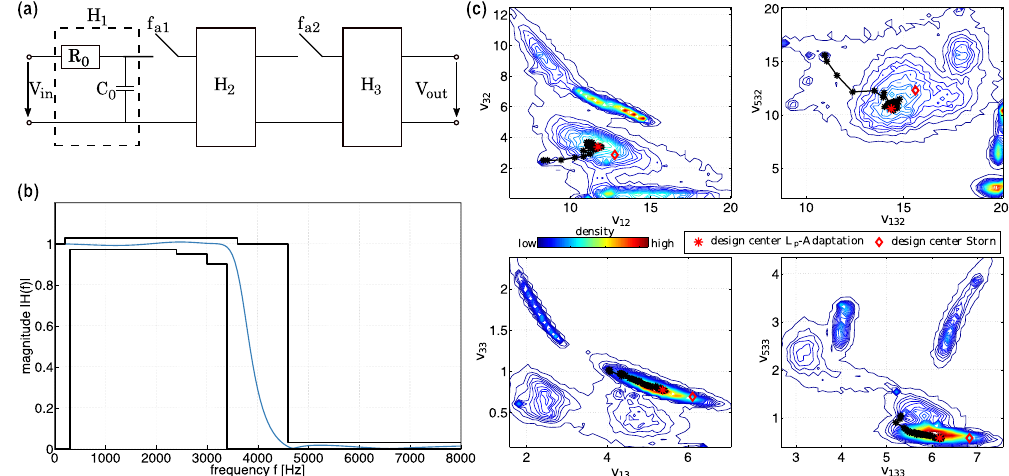
Figure 6. ( a ) Circuit diagram of the Switched Capacitor (SC) filter. ( b ) Specifications for the transfer function of the filter (black lines) and one example satisfying the constraints (blue line). ( c ) Pairwise density contour plots of the feasible points obtained by ten runs of L p -Adaptation with different starting points in the nine- dimensional design space. The black trajectory show the evolution of the mean for the run that yielded the largest volume approximation. The red star is the final design center obtained by that run. The design center found by Storn 15 in the same part of the feasible region is indicated by the red